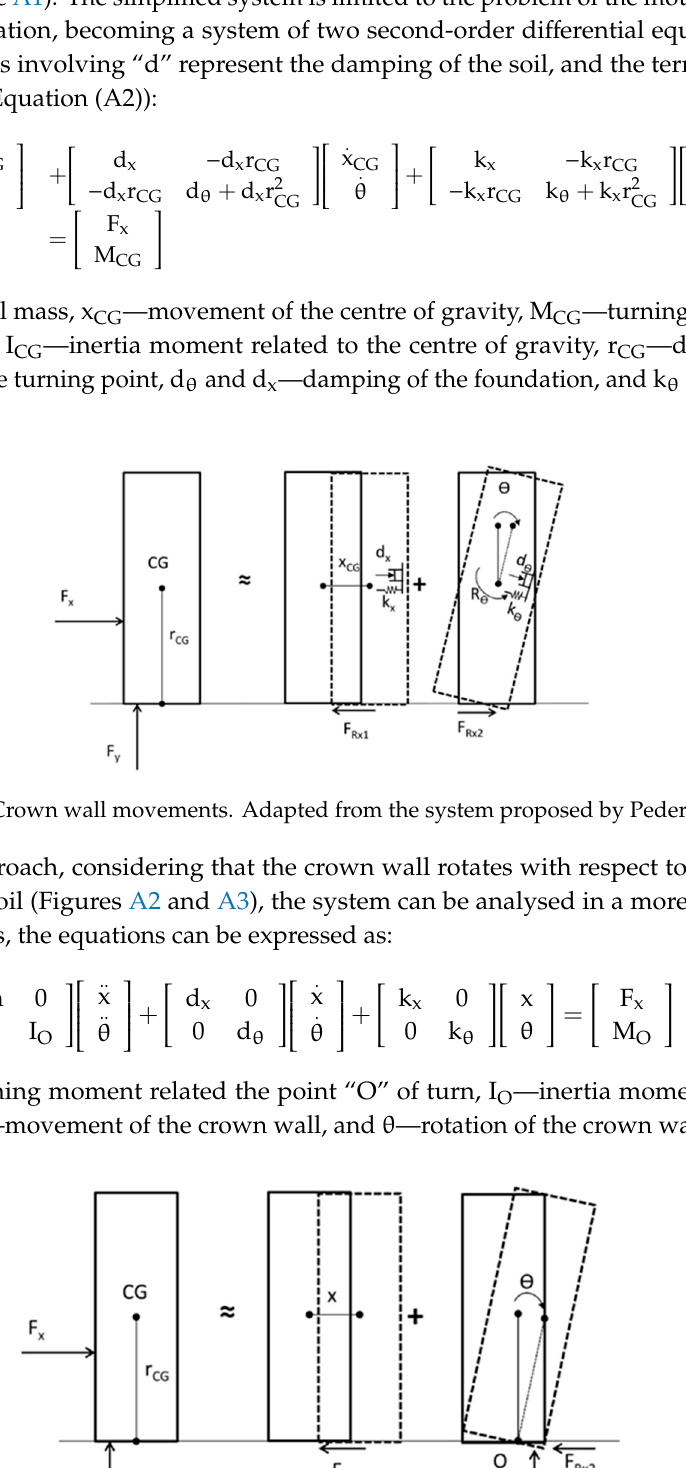
Figure A2. Scheme proposed of the dynamic system . (CG—centre of gravity; r CG — radio of rotation of the center of gravity, ϴ —gyro; and F R —resistance of the soil to the movement).